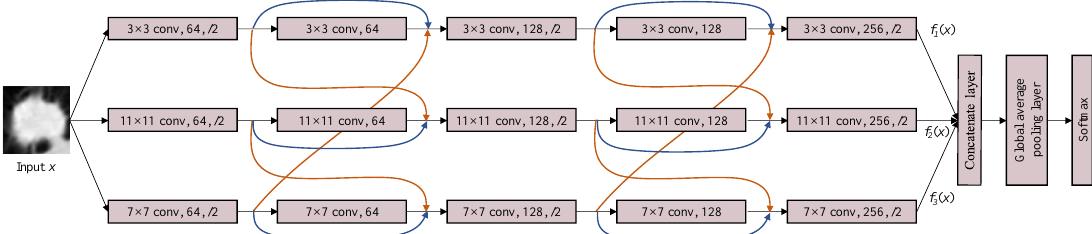
Figure 3. The diagram of the multi-level cross residual neural network. The input x is inputted into three parallel levels which have the same structure but different convolution kernel sizes. ML-xResNet contains two xRes blocks and three normal convolutional layers as well as max-pooling layers. Then, fusing the outputs of three levels by the concatenate layer, and through a global average pooling layer, the final result can be obtained by the softmax